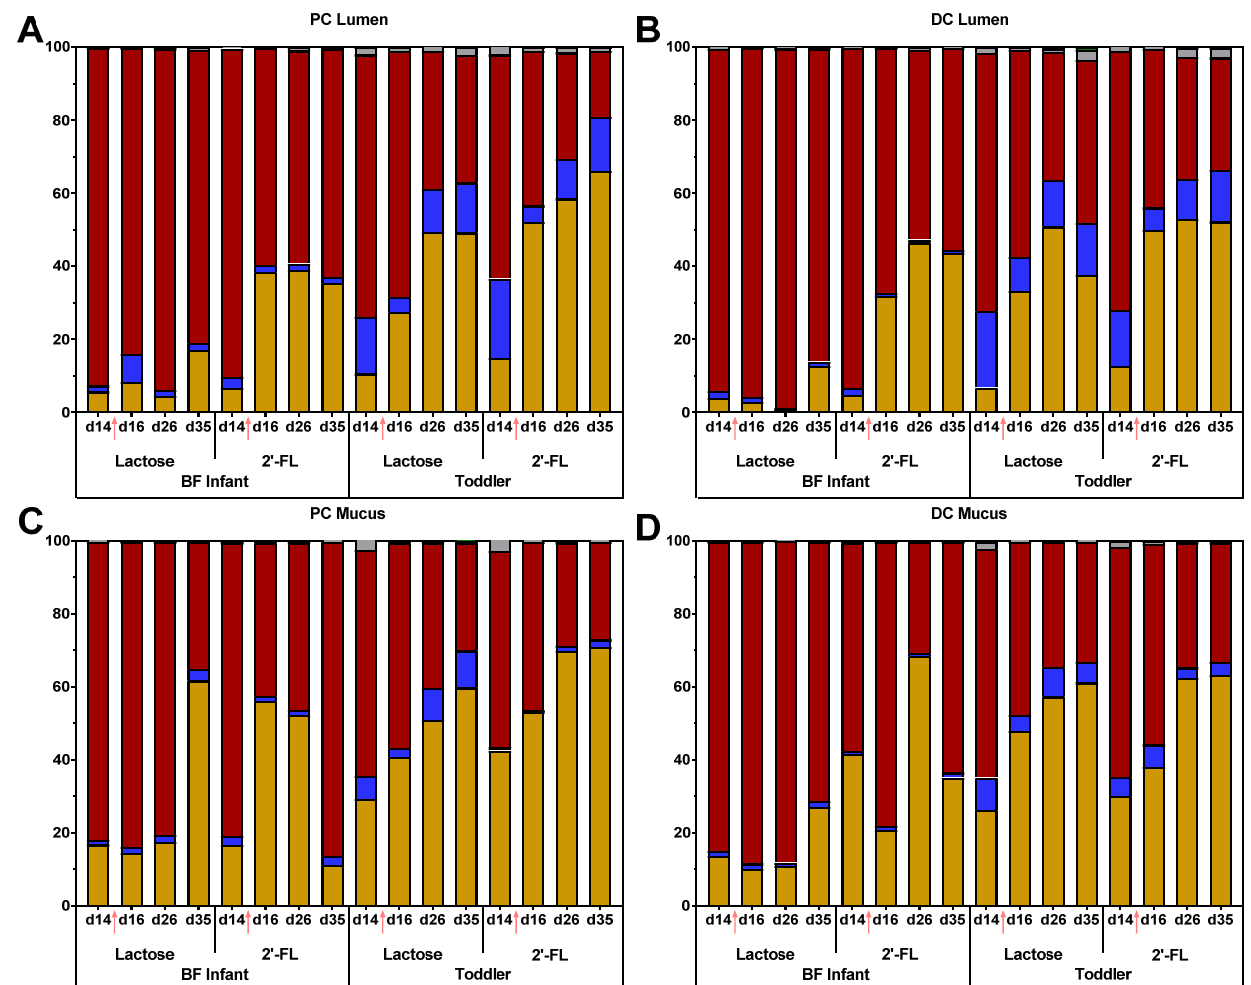
Figure 5. Effect of long-term administration of lactose or 2’-FL on infant and todder microbiota in vitro. Stacked bars represent proportional abundance at the phylum level (%) for BF infant or toddler microbiota before (d14) and after treatment with lactose or 2’-FL (d16, d26, and d35) in the M-SHIME ® : ( A ) PC lumen, ( B ) DC lumen, ( C ) PC mucus, ( D ) DC mucus. BF = breastfed; 2’-FL = 2’fucosyllactose; d = day; PC = proximal colon; DC = distal colon; M-SHIME ® = mucosal simulator of the human intestinal microbial ecosystem. Arrows indicate the start of treatment with lactose or